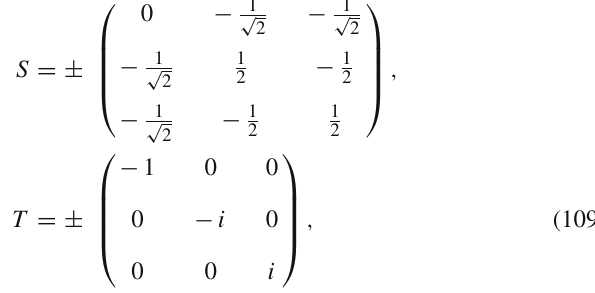
Table 5 The ten symmetric generalised CP transformations X = ρ( g ) consistent with the S 4 flavour symmetry for the triplet representation ρ in the chosen basis [136], determined by the consistency condition in Eq. (100). The mapping ( T , S ) → ( ˆ T , ˆ S ) is realised via the consistency condition applied to the group generators T and S , i.e., X ρ ∗ ( T ) X − 1 = ρ( ˆ T ) and X ρ ∗ ( S ) X − 1 = ρ( ˆ S ) . E denotes the identity element of S (From